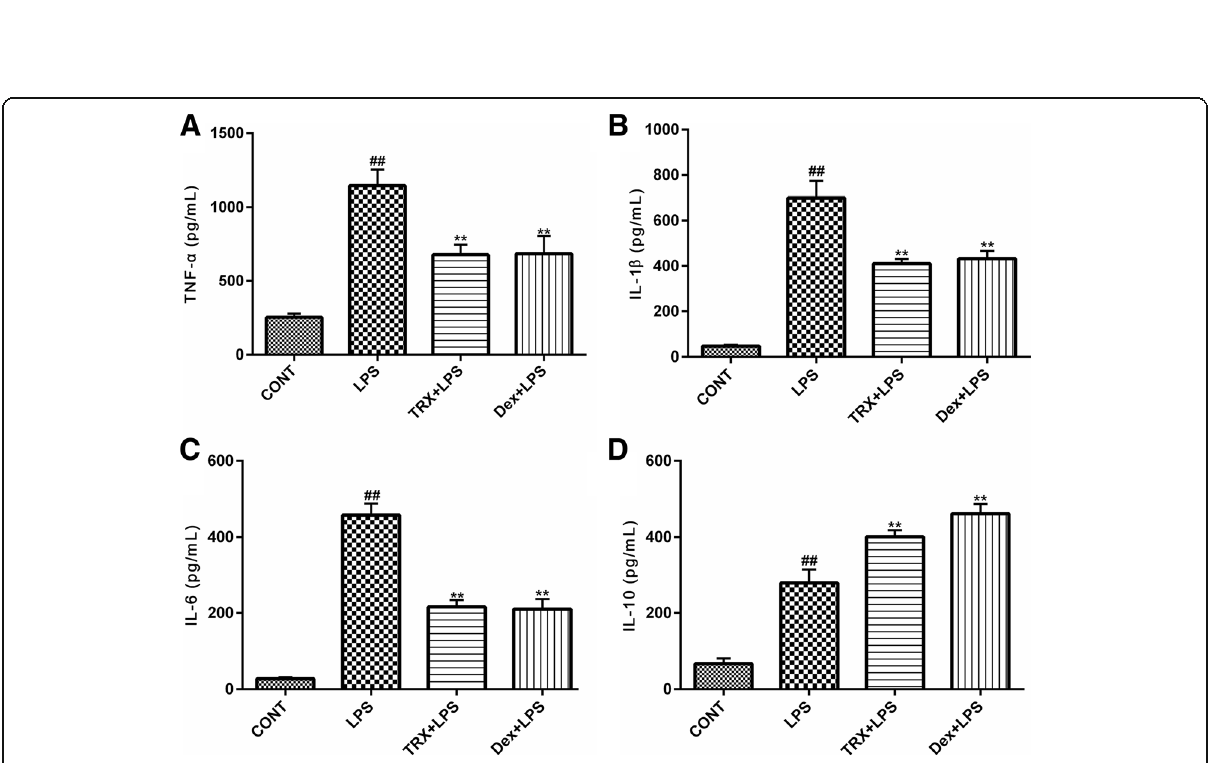
Fig. 6 The effects of TRX on concentrations of the pro- and anti-inflammatory cytokines in BALF from mice with LPS-induced ALI. BALF were harvested to analyze the TNF- α ( a ), IL-1 β ( b ), IL-6( c ) and IL-10( d ) using specific ELISA kits. The data presented are the mean ± SEM (n = 6 – 8). # P < 0.05, ## P < 0.01 compared with control group, * P < 0.05, ** P < 0.01 compared with LPS group (one-way